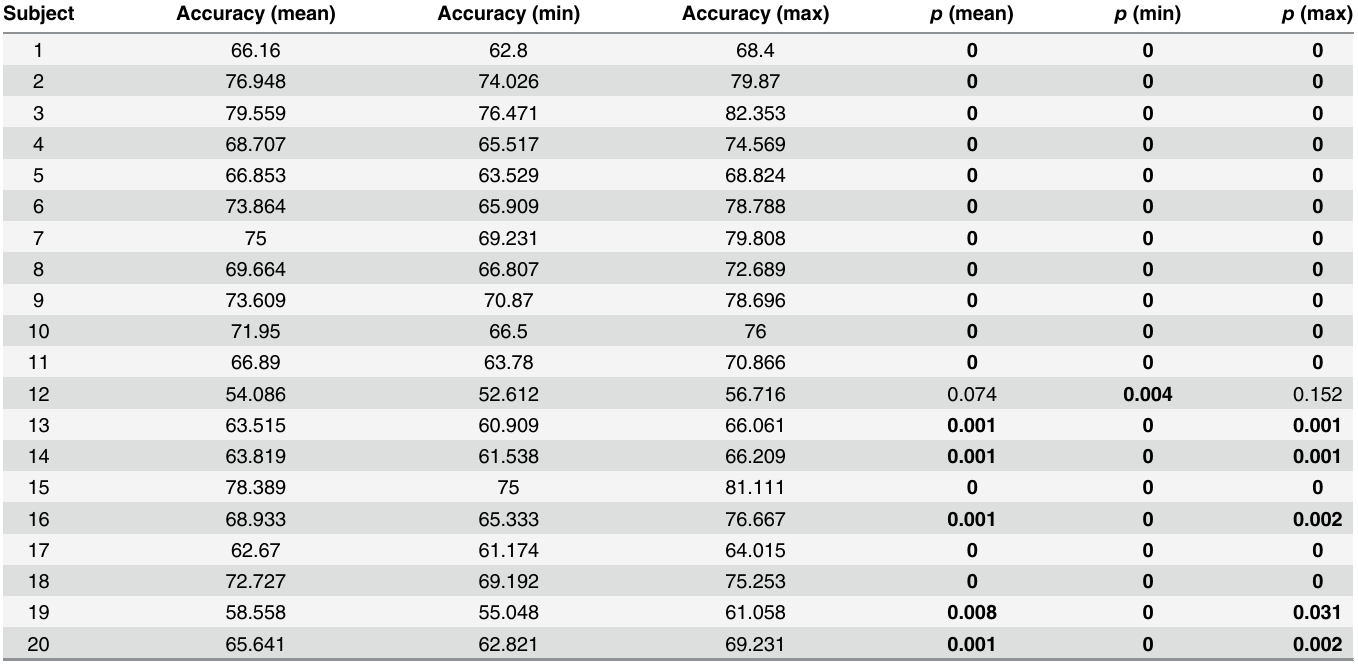
Table 5. Results Flanker Task Ne